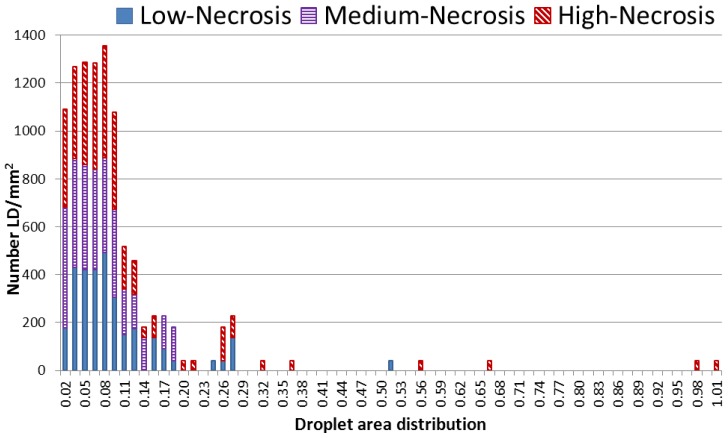
Distribution of lipid droplets for droplet area between 0 and 1.005 μm2 in bins of 0.015 μm2. The x-axis represents droplet area distribution and the y-axis—droplet density (number LD/mm2). The red, purple and blue bars represent the mean number of LD in high (>70%) medium (40%–70%) and low (<40%) necrosis, respectively.